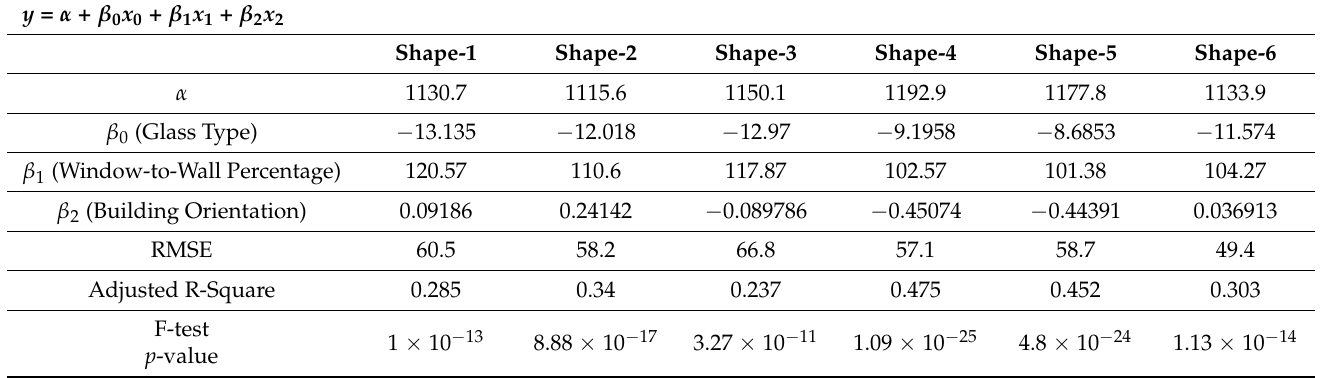
Table 9. WWR multi-linear regression equation.